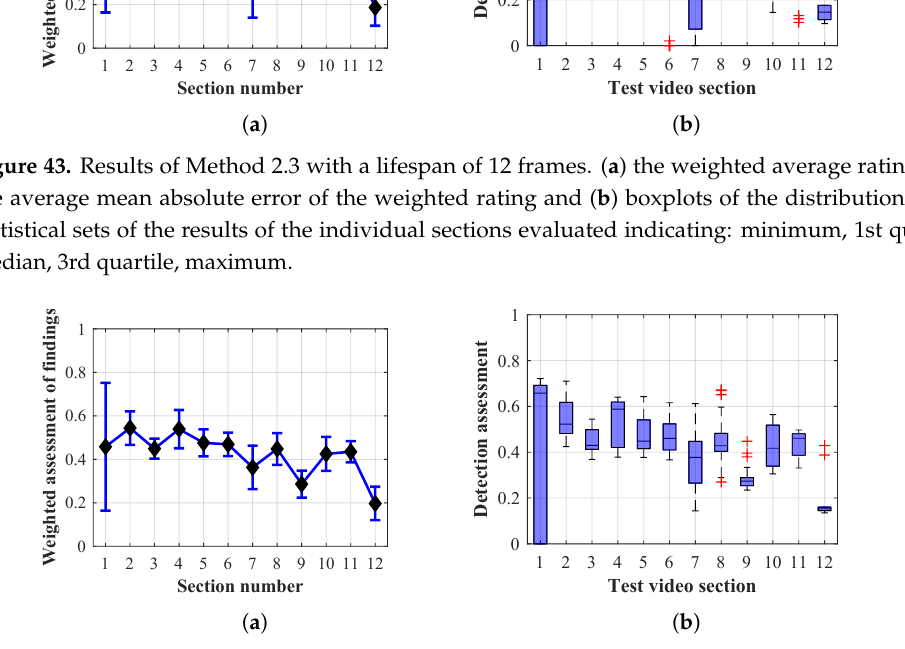
Figure 44. Results of Method 2.3 with a lifespan of 40 frames. ( a ) the weighted average rating with the average mean absolute error of the weighted rating and ( b ) boxplots of the distribution of the statistical sets of the results of the individual sections evaluated indicating: minimum, 1st quartile, median, 3rd quartile,